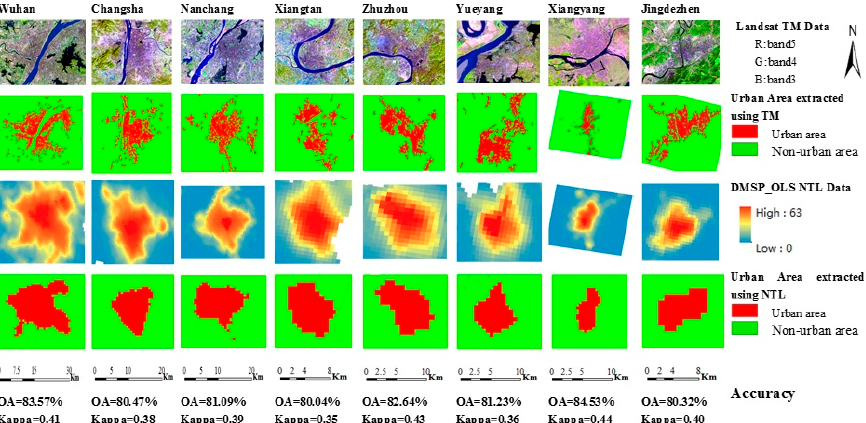
Figure 5. Accuracy assessment of extracted urban areas from nighttime light (NTL) data through comparison with the classified maps of Landsat TM images in 2009.